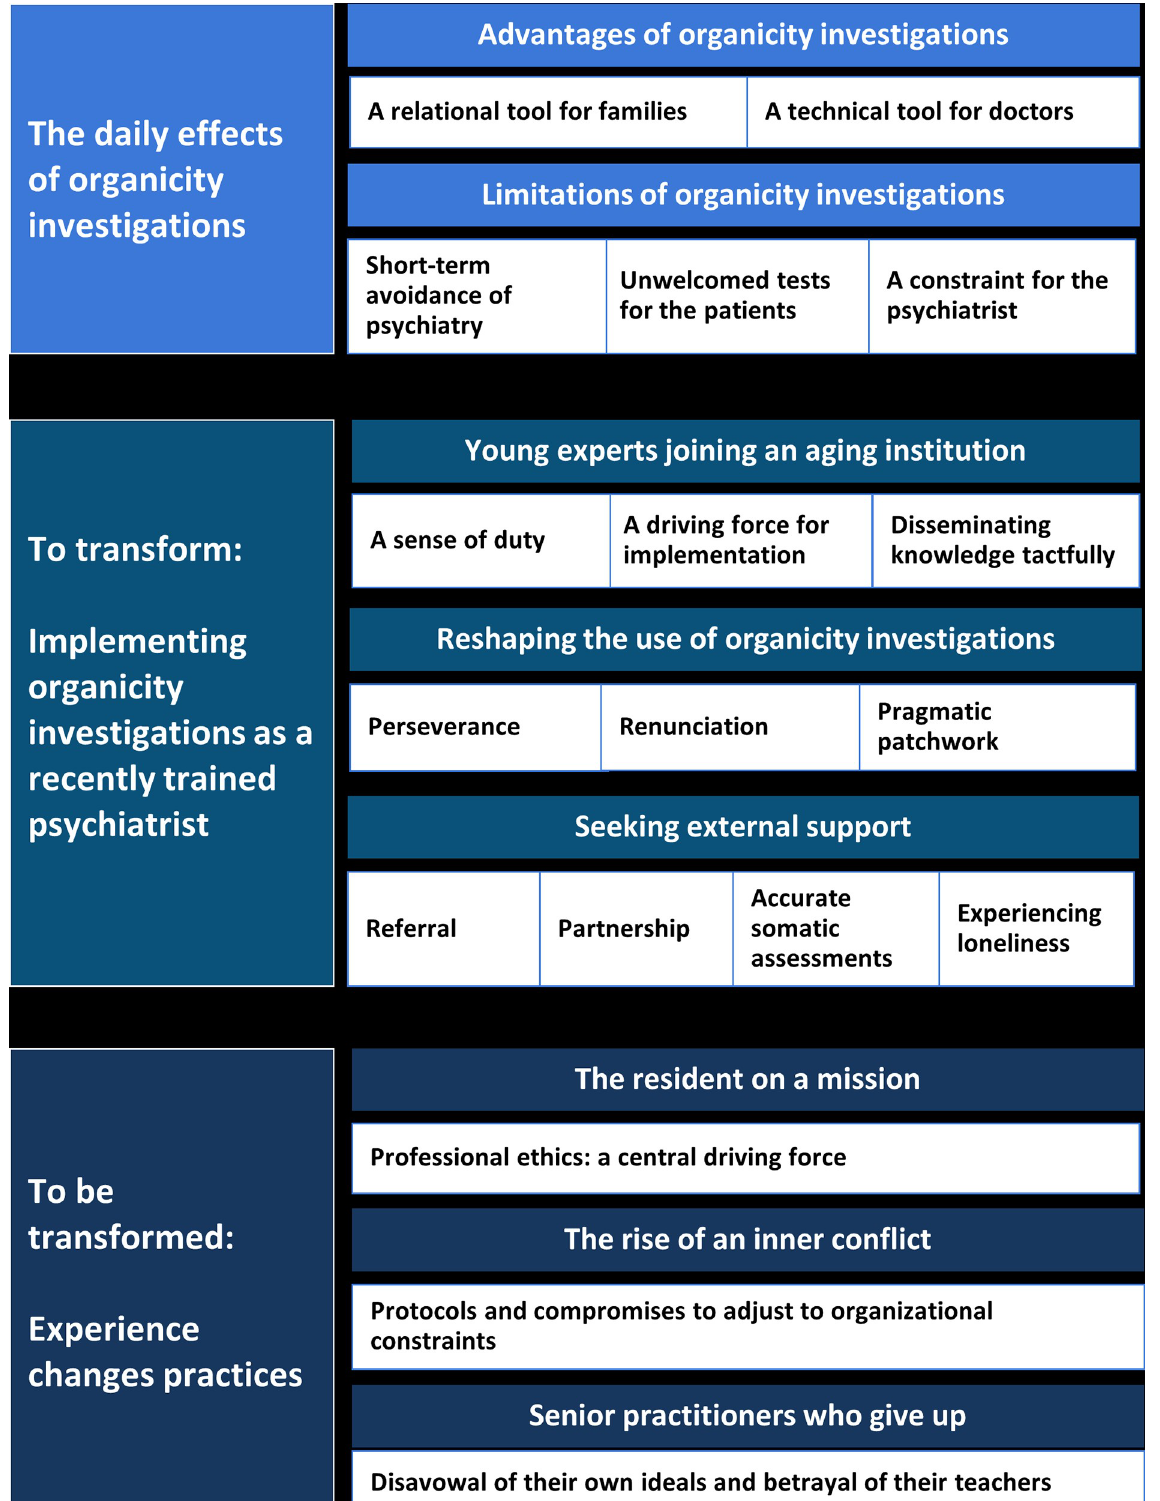
Fig 1. Main results—the challenges of organicity investigations implementation in psychosis.